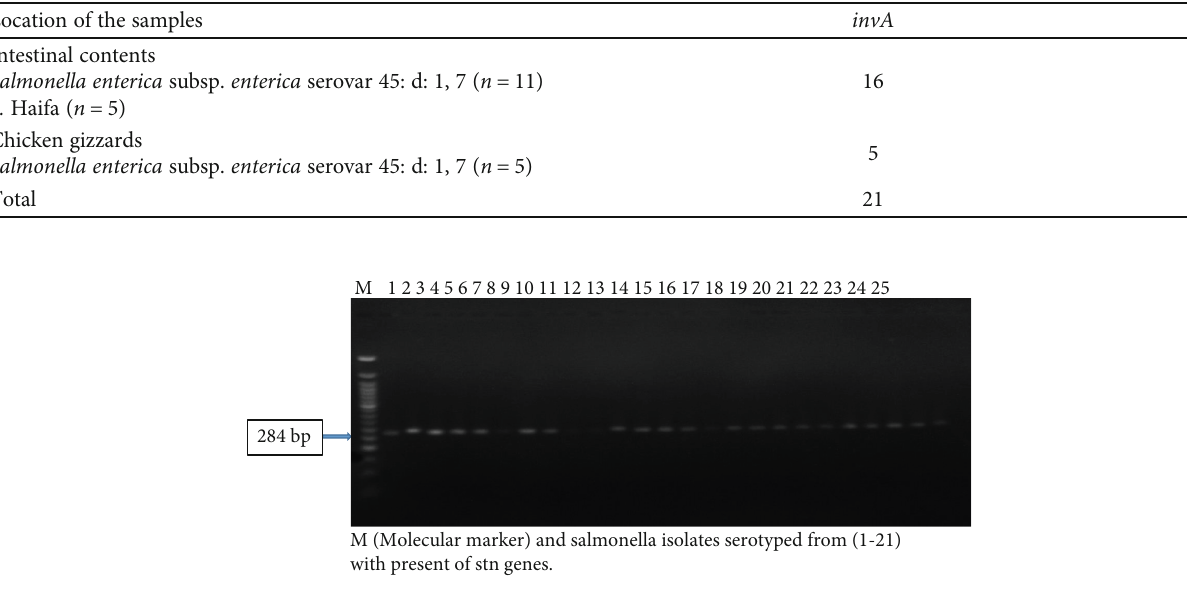
Figure 2: Ampli fi cation of the stn gene from Salmonella serovars from intestinal contents and ready-to-eat chicken gizzards from the Ilorin metropolis.